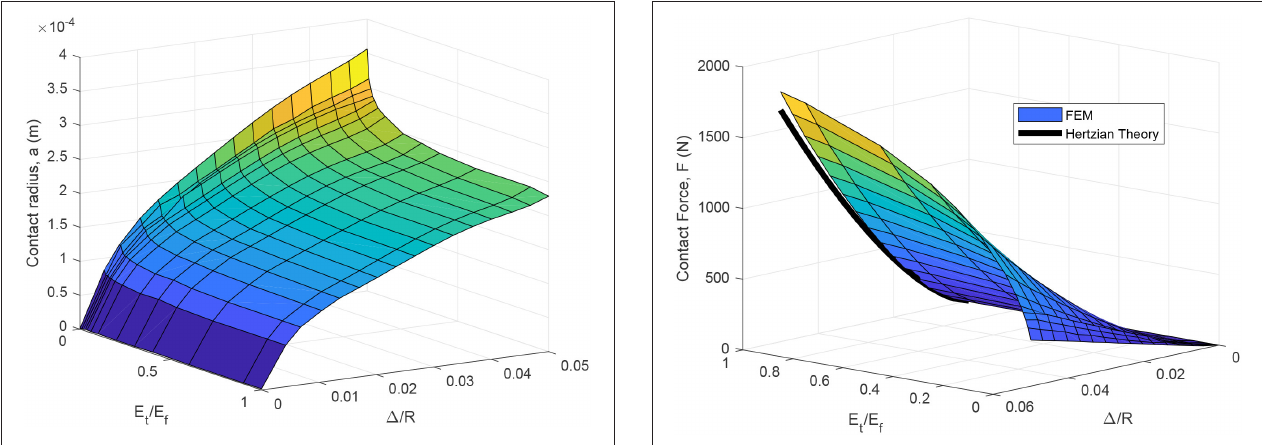
E t / E f 0 to 1. The position of the highest point at the profile = of the flat top surface is used to measure the pile-up height.